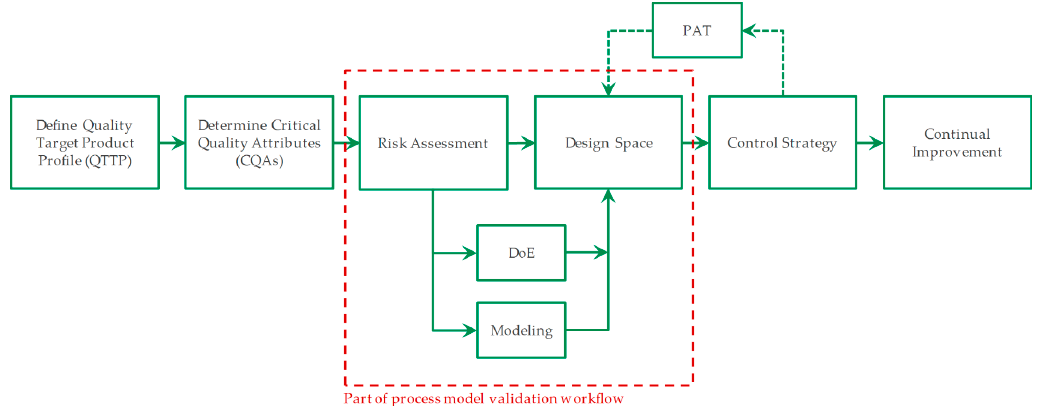
Figure 1. Process model validation workflow and its position in the overall Quality-by-Design (QbD)-based process development strategy. Adapted from [13]. After the definition of the quality target product profile and determination of critical quality attributes, risk assessment and design space identification can either be obtained by experiments or by modeling.